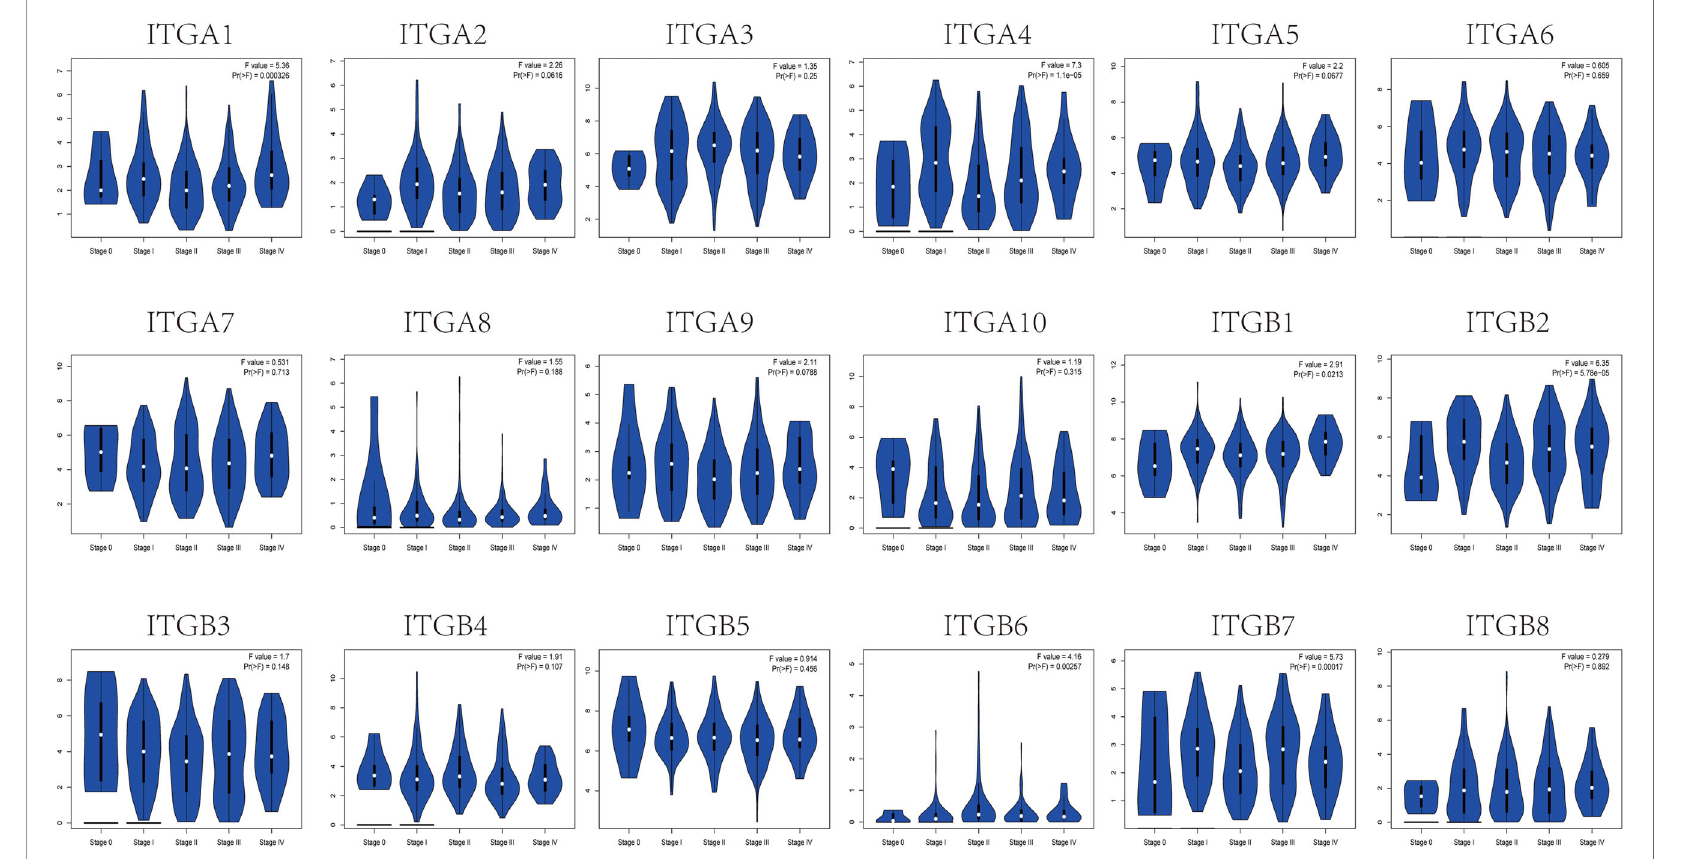
FIGURE 3 | Correlation between different expressed integrin subunits and the pathological stage of SKCM patients (GEPIA). A P value less than 0.05 was used to determine statistical difference. Student ’ s t test was used to generate a p value for expression or pathological stage